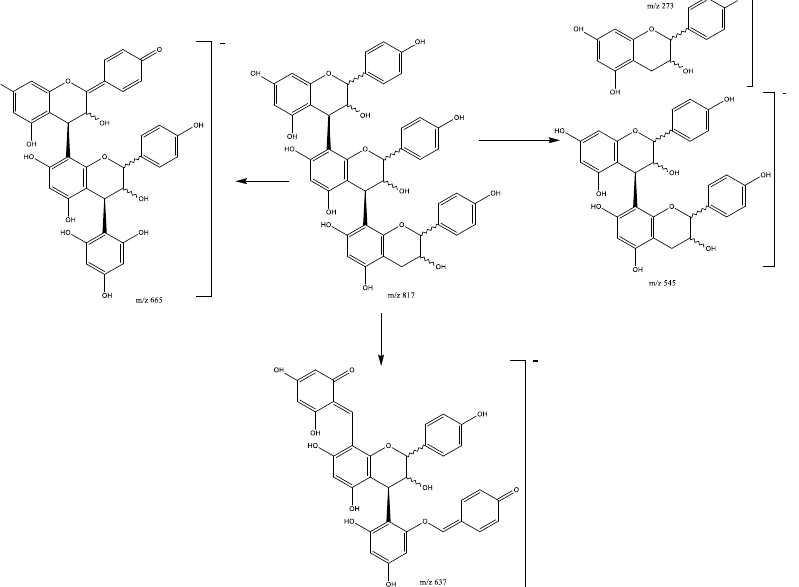
Figure 8. Propelargonidin (epi)afzelechin-(epi)afzelechin-(epi)afzelechin B-trimer fragmentation pattern. Eight propelargonidin B-type trimers with two (epi)afzelechin subunits and one (epi)catechin subunit were found in peaks 3 (Rt = 7.33 min), 19 (Rt = 14.56